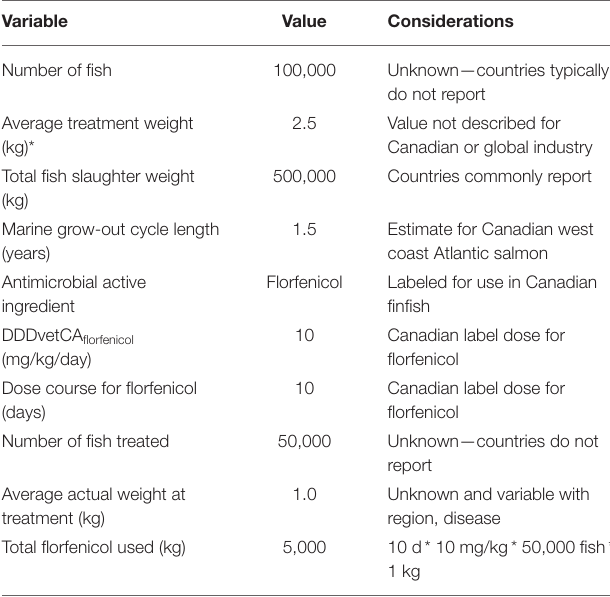
TABLE 2 | Hypothetical data for derivation of antimicrobial use indicators for finfish